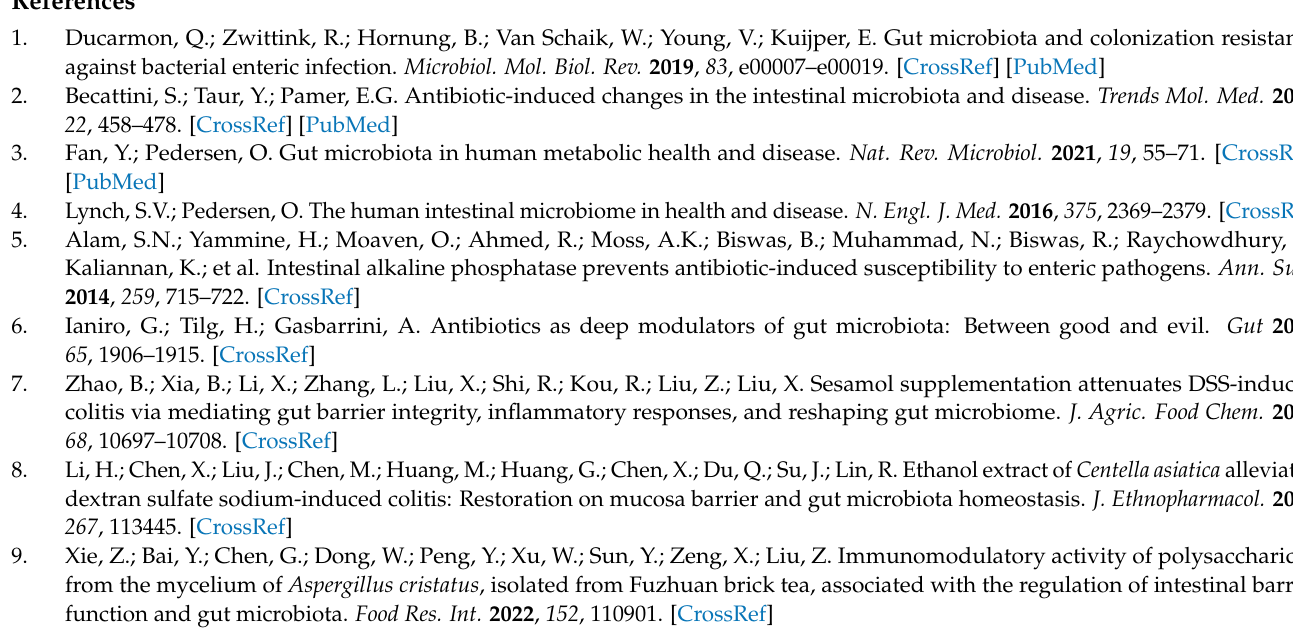
Figure S3: The effects of excessive ceftriaxone sodium on gut microbiota; Figure S4: The effects of excessive ceftriaxone sodium on SCFA